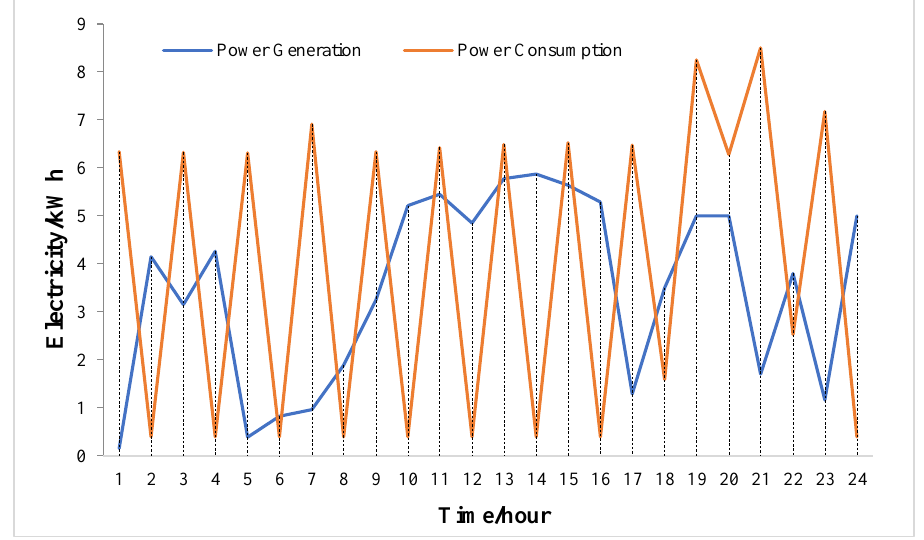
Figure 4. The change in power generation and electricity consumption before VES.